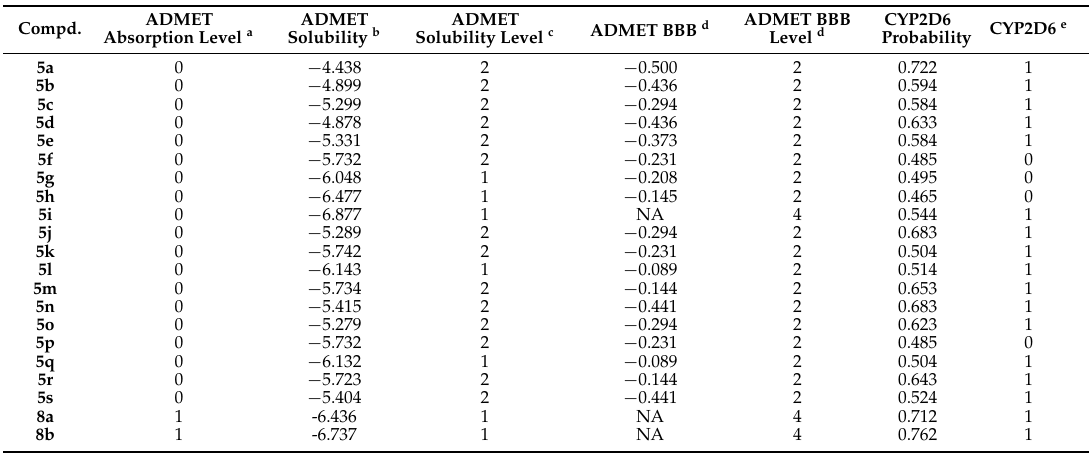
Table 3. ADME studies results for all the synthesized